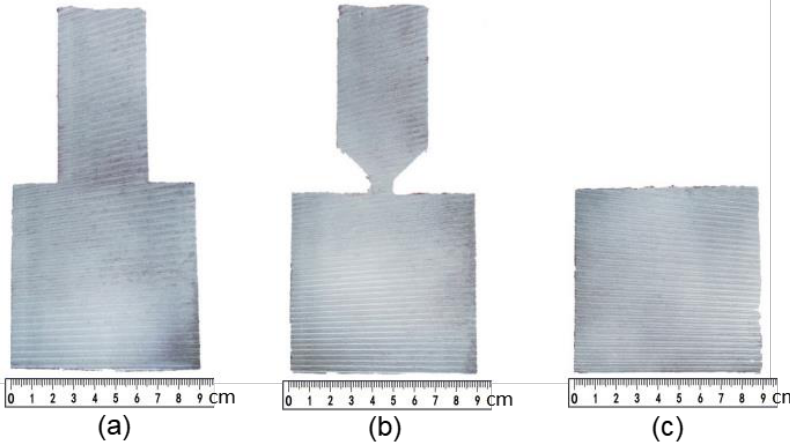
Figure 9. Cross-section topography of the prototypes poured at 1250 °C: ( a ) Prototype A3, no macro porosity or surface sink was found; ( b ) Prototype B3, no macro porosity or surface sink was found; ( c ) Prototype C3, no macro porosity or surface sink was found.